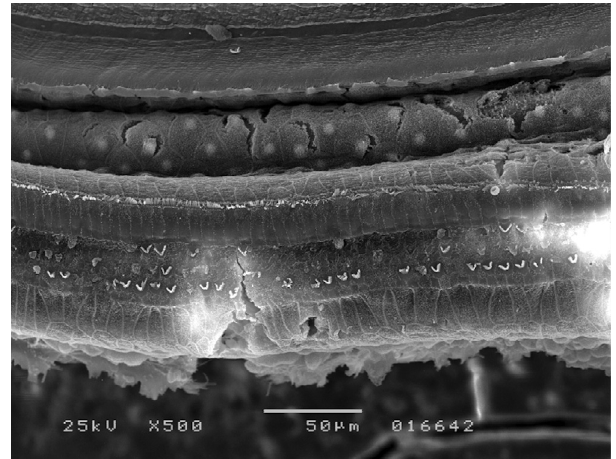
Figure 5 Photo from Expt group (scanning electron microscopy), 500 ×